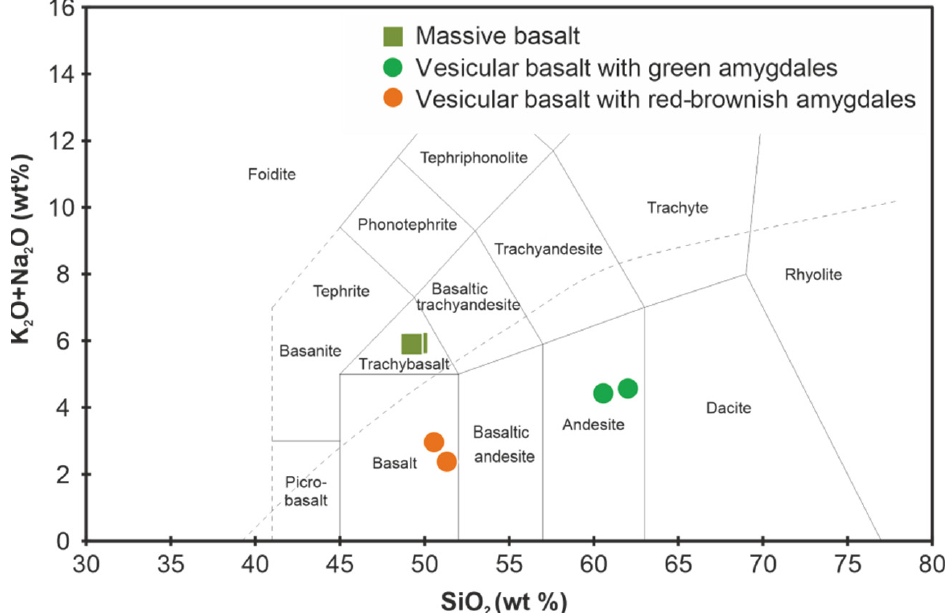
Figure 4. Total alkali silica (TAS) diagram classification (after [24]) of volcanics from the Priozersk Formation within the Pasha–Ladoga Basin. Formation within the Pasha–Ladoga